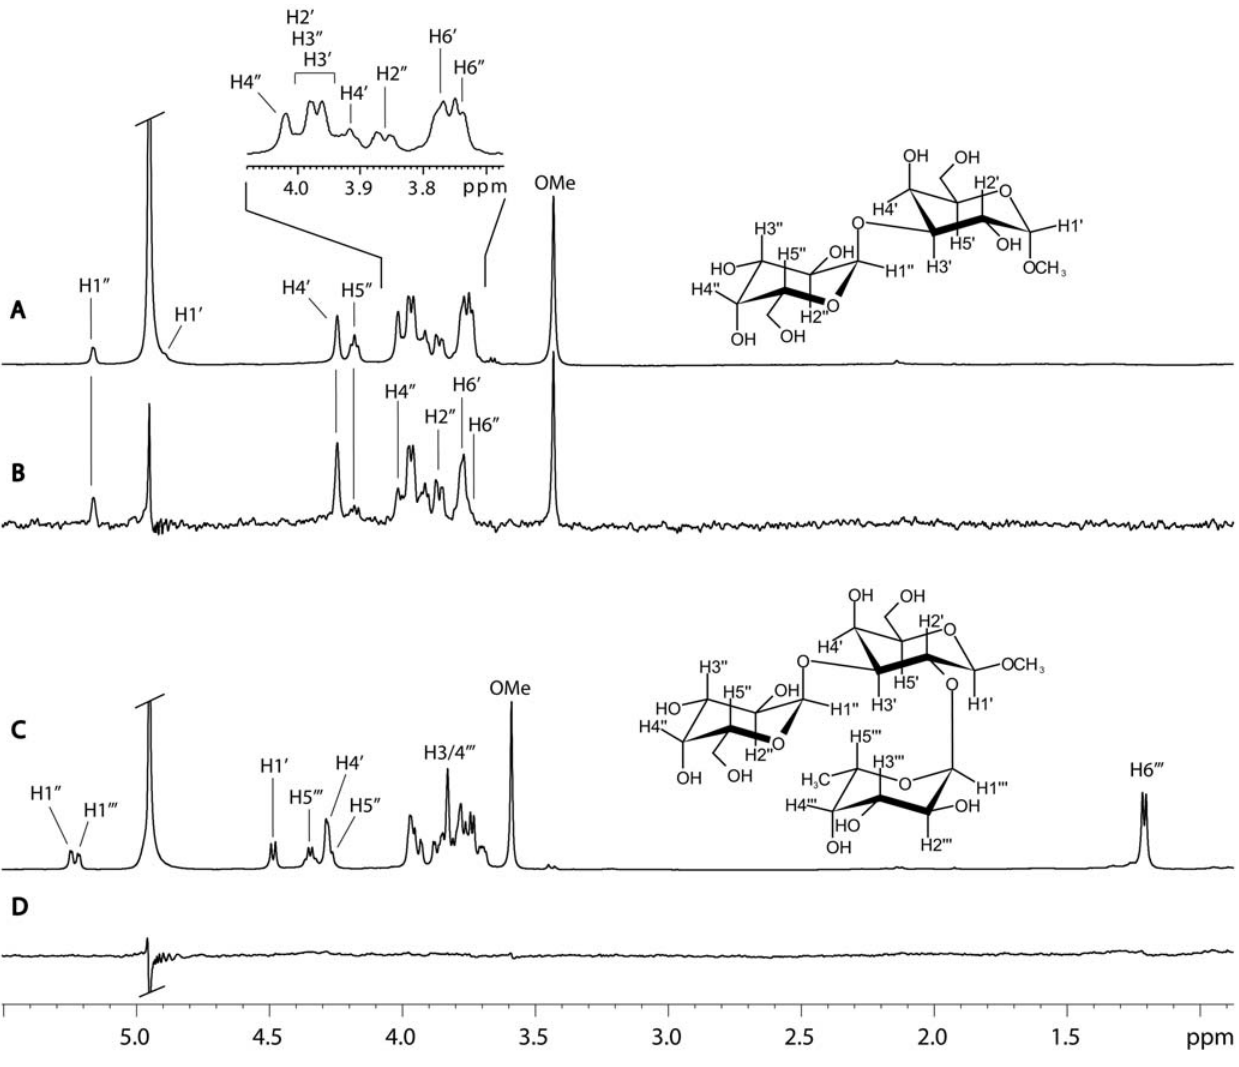
Figure 6. Observation of STD signals for the a Gal disaccharide and the blood-group B trisaccharide. (A) Reference 1 H NMR spectrum and (B) STD NMR spectrum of Gal a 3Gal a OMe in the presence of bovine norovirus VLPs. (C) Reference 1 H NMR spectrum and (D) STD NMR spectrum of the methyl glycoside of the blood group B-trisaccharide in the presence of bovine norovirus VLPs. STD signals are only observed for Gal a 3Gal a OMe. The blood group B-trisaccharide shows no STD effects, and is therefore not recognized by the VLPs. Spectra were recorded at 500 MHz at a temperature of 282 K with 256 and 816 scans, respectively.